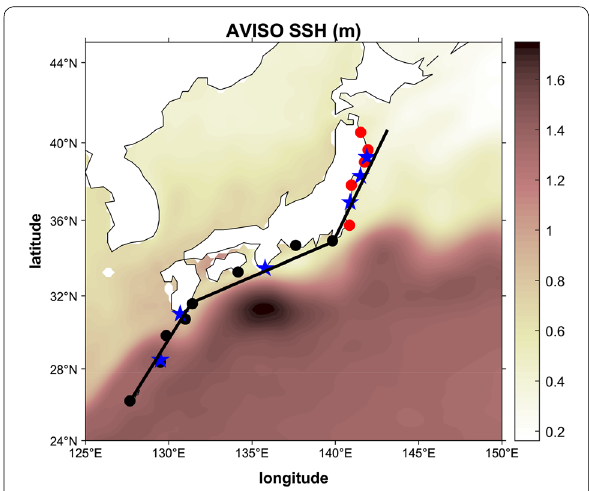
Fig. 1 The tide gauge stations south (black dots) and north (red dots) of the KE jet superimposed with mean sea surface height (SSH) from AVISO from 1993 to 2018. The black lines represent the alignment of alongshore wind. The six blue stars denote the tide gauge stations for sea level tests